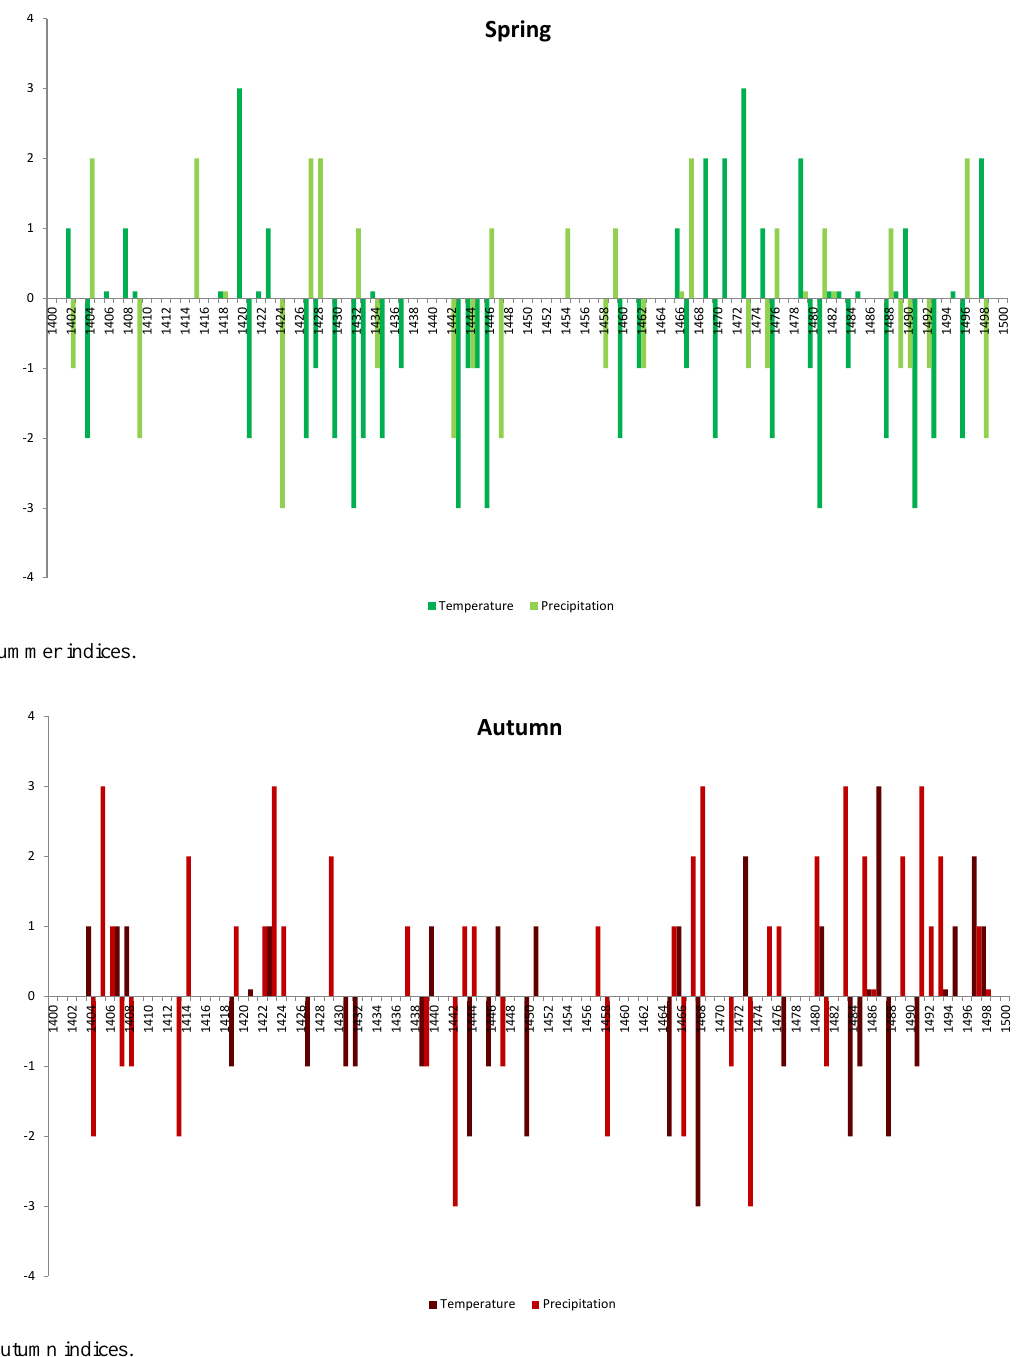
Figure 7. Autumn